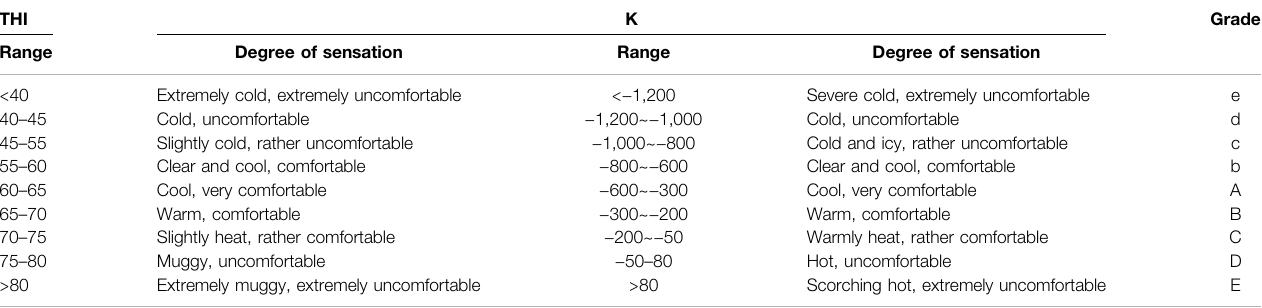
TABLE 1 | The grading standards of biometeorology suitability